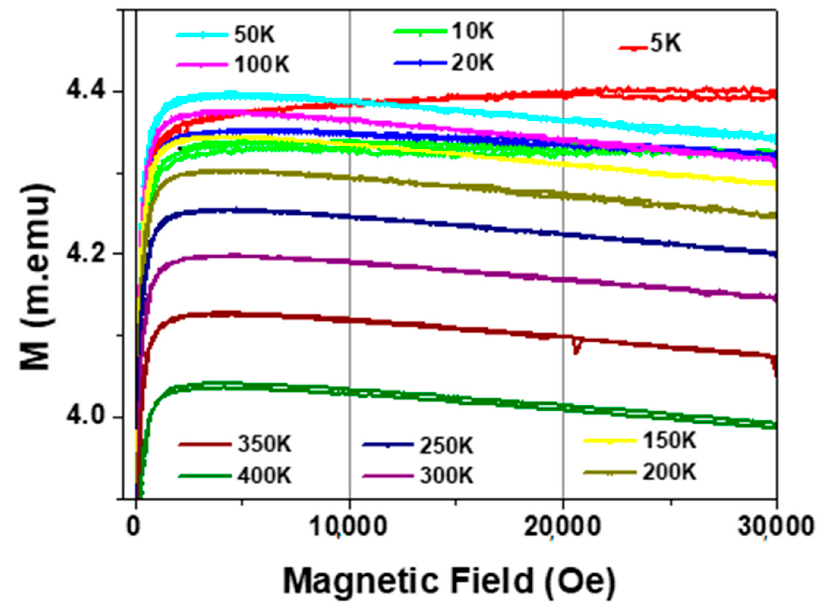
Figure 4. Magnetization vs. magnetic field curves of as-prepared Co 2 MnSi glass-coated microwires. All loops have been measured at a temperature range from 400 K to 5 K.